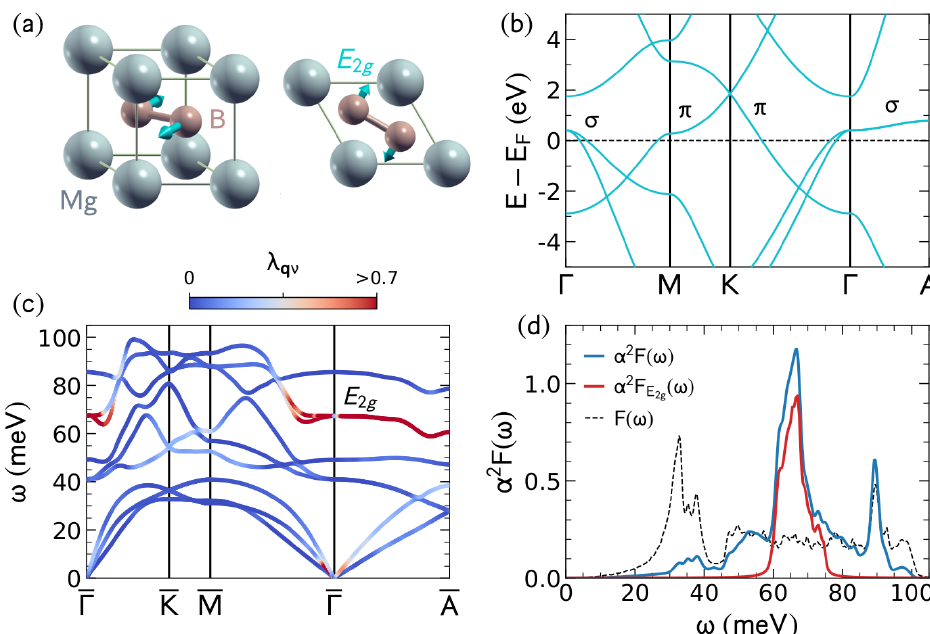
Figure 1: (a) Crystal structure of MgB . Also displayed are the lattice displacements 2 of the in-plane E mode at q = 0. (b) Electronic band dispersion of MgB . Bands are 2 g 2 labelled as σ - and π -bands according to their symmetry. (c) Phonon dispersions of MgB . The color code (color bar atop) represents the strength of the el-ph coupling 2 λ . (d) Corresponding phonon density of states F ( ω ) (dashed line) and the total q ν Eliashberg function α 2 F ( ω ) (blue solid line). The solid red line shows the contri- bution to the Eliashberg function associated with the hot E modes. Readaptation 2 g from Ref. [ 37 ]